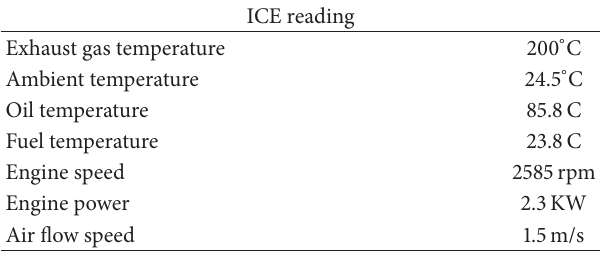
Table2:ReadingsofICEpoweredbyJordaniangasoline/octanerate 95 after 135 seconds at beginning of the engine operation.